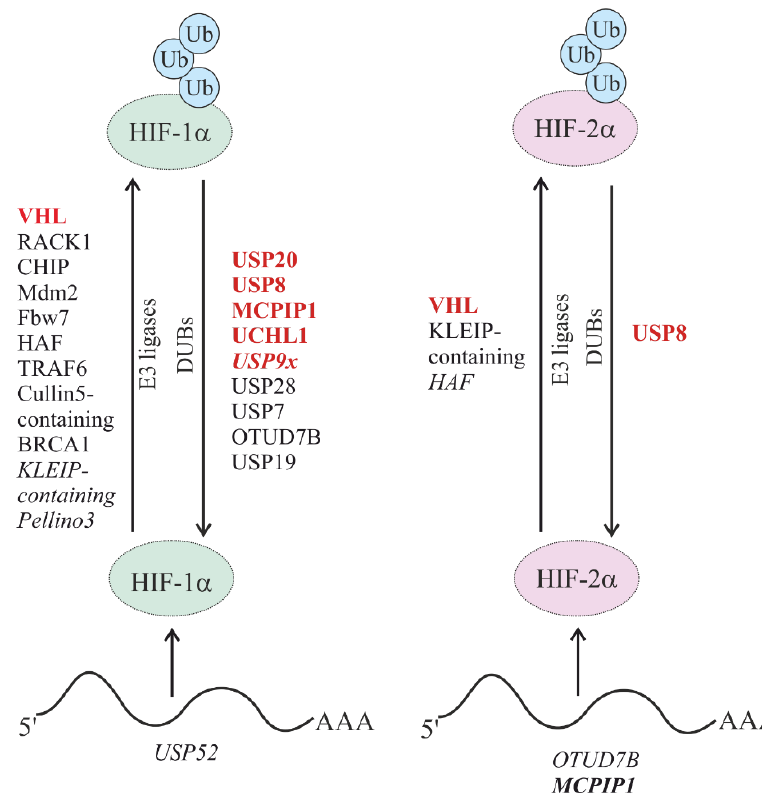
Figure 4. E3 Ub-ligating and deubiquitinating enzymes (DUBs) involved in hypoxia-inducible factor (HIF)-α stability and signaling. DUBs and E3 Ub ligases involved in the oxygen-dependent regulation of HIF-1α and HIF-2α degradation are depicted in red. DUBs and ubiquitin E3 ligases involved in oxygen-independent regulation of HIF degradation are depicted in black. DUBs involved in the regulation of HIF mRNA stability and/or expression are depicted in blue. Non-enzymatic and/or indirect regulations are indicated in italics.